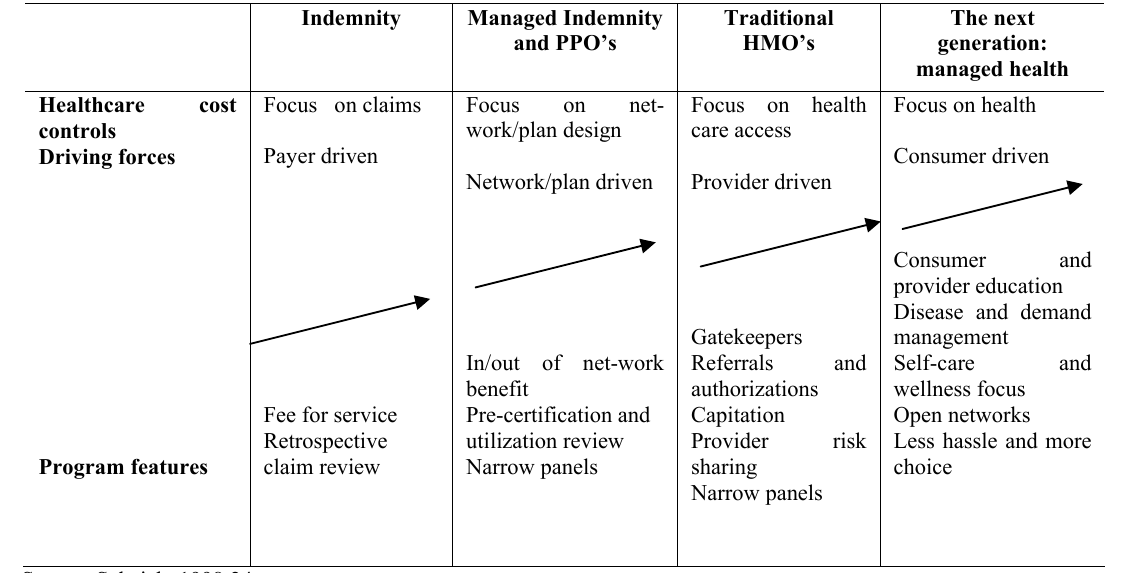
Table 2: The evolution of health plans